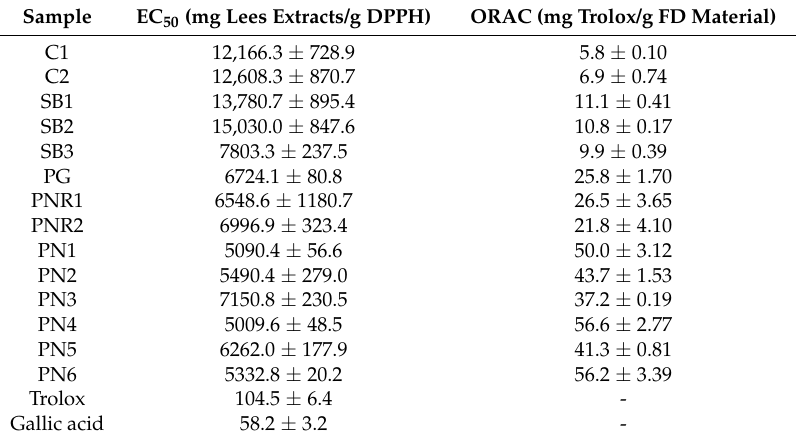
Table 3. Summary of antioxidant activity of wine lees